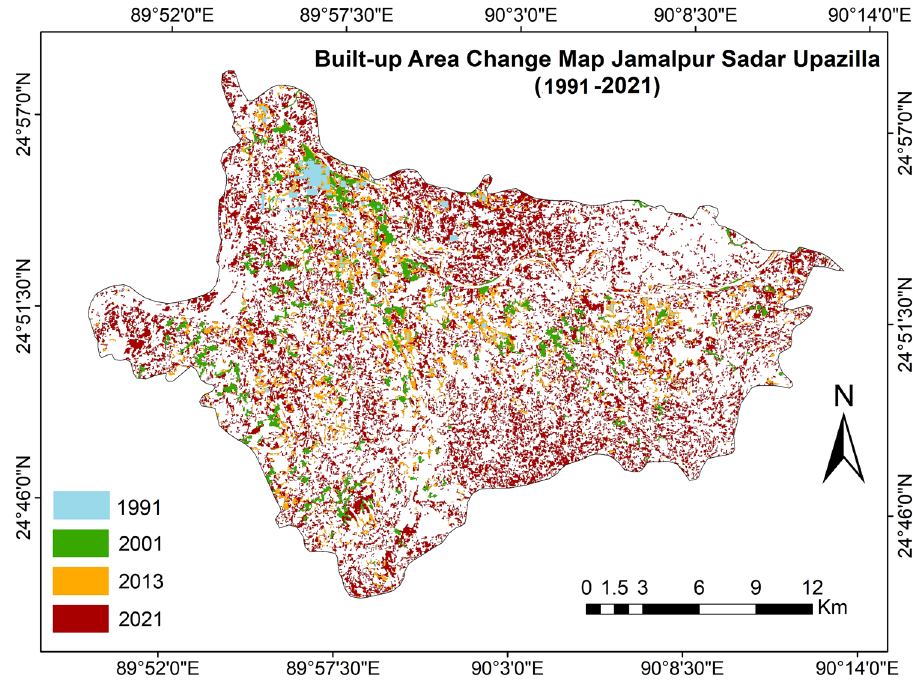
Fig. 7 Map showing expan- sion of built-up area